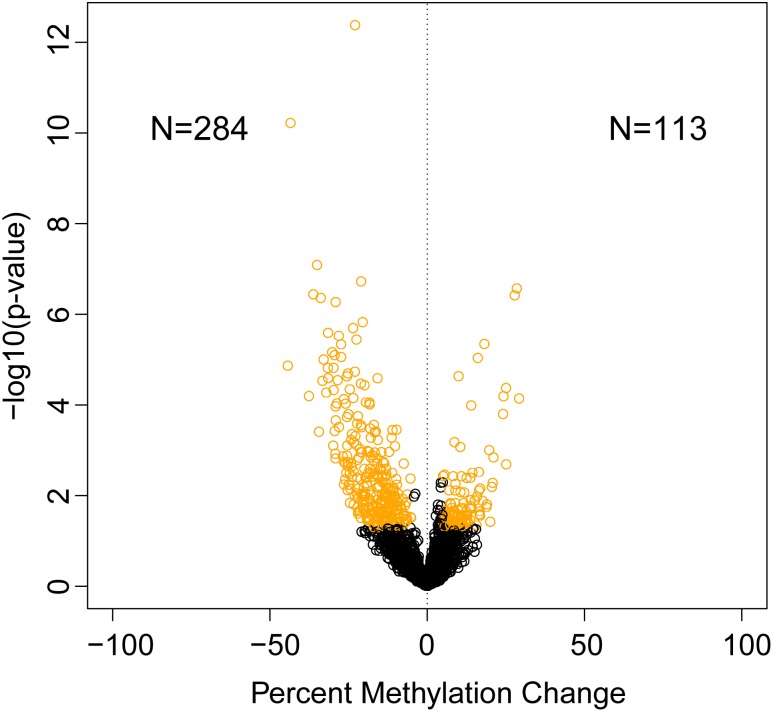
Identification of significantly differentially methylated sites between dioxin treated and untreated zebrafish gonads. Volcano plot depicting percent methylation change and p-value of methylated sites (circles). Significantly changed CpG sites (percent methylation change 5%; p-value ≤ 0.05) are in yellow.